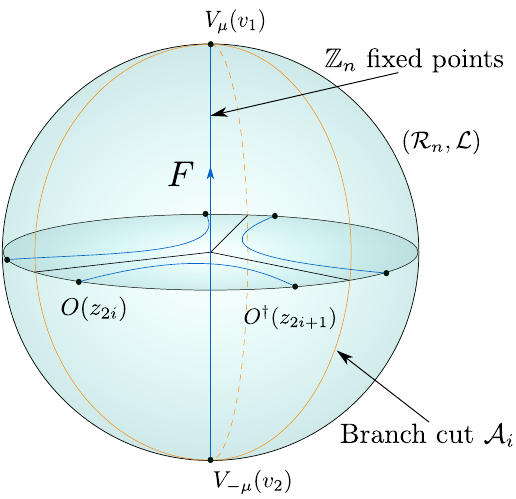
Figure 1. For a single entangling interval, the universal covering of the replica n -fold is a Riemann sphere. There are n copies of excitations on the replica n -fold. The blue lines represent the bulk Wilson lines dual to the boundary excitations. The orange lines represent the branch cuts between the n sheets in the original replica